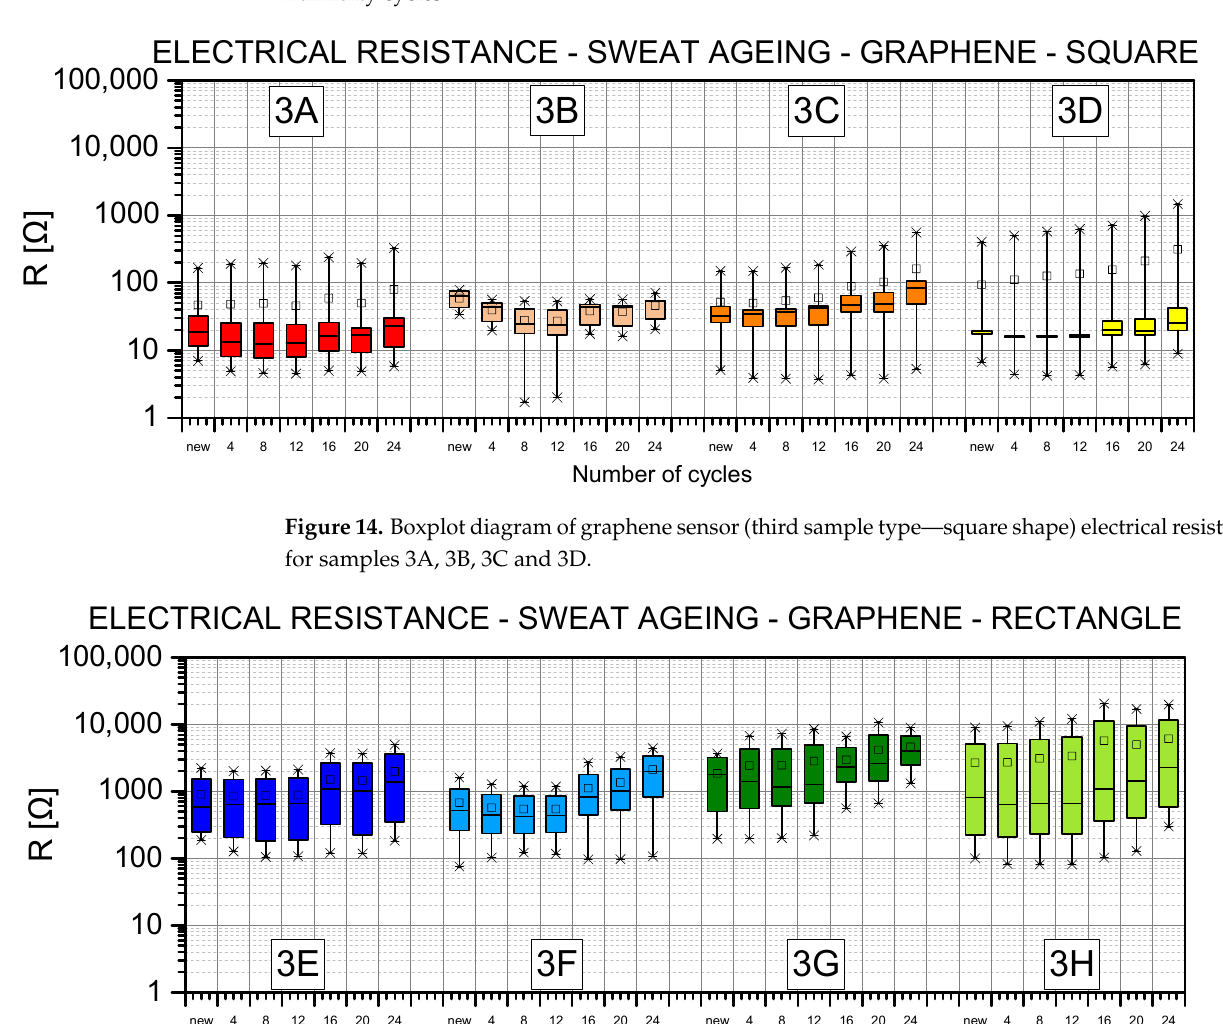
Figure 16. Medians of electrical resistance for the third sample type tested under sweat for sam ‐ ples 3A, 3B, 3C, 3D, 3E, 3F, 3G and 3H. The samples after the whole aging process (i.e., 823 h in sweat) were submitted for observations to find visual changes (see Figure 17). The degradation of conductive lines is clearly visible, with a higher intensity for samples aged in acidic sweat. However, encap ‐ sulation clearly fulfilled its purpose, and the joint under encapsulation was protected against sweat.